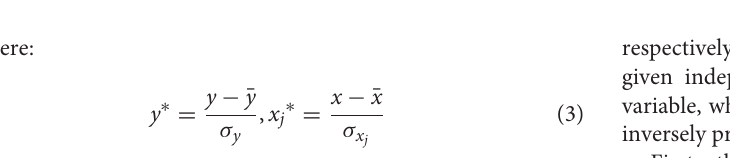
FIGURE 9 | Energy and comfort performance in the dwelling for different occupant profiles, colored by annual window opening, reporting on hot discomfort (A,B) , cold discomfort (C,D) , and total discomfort (E,F) as a function of heating demand for two WWR values (13% on the left and 40% on the